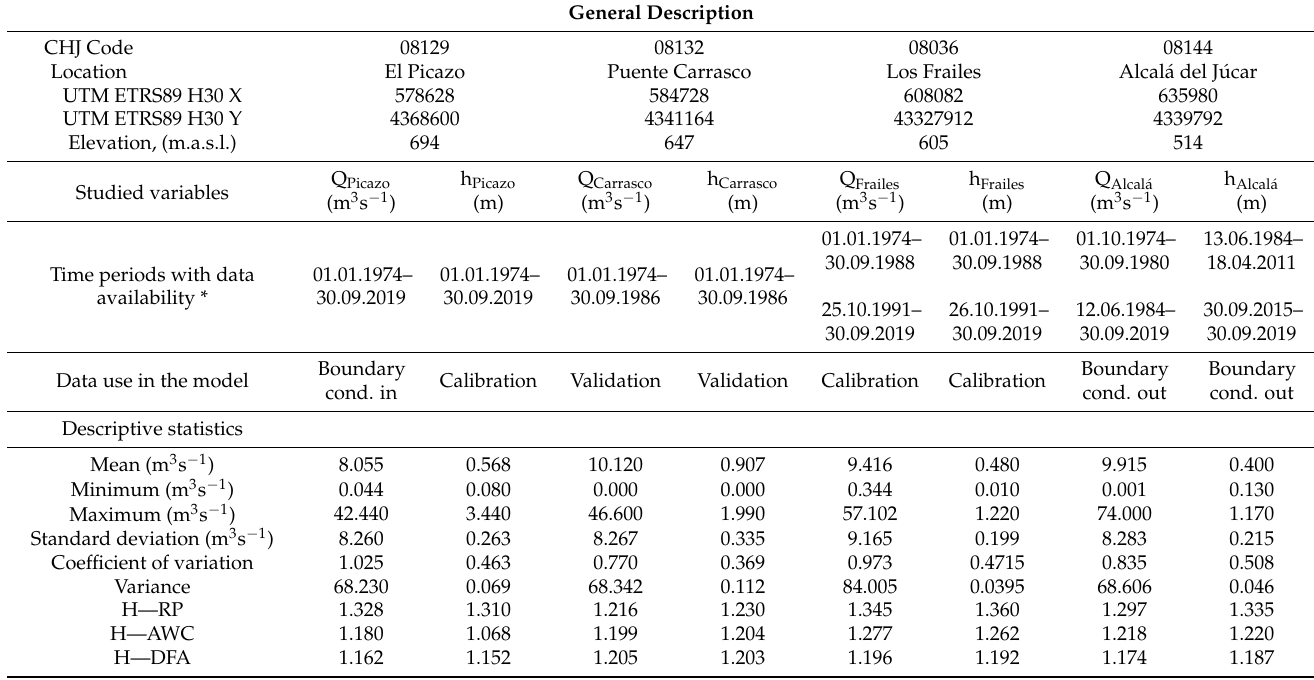
Table 1. General description and descriptive statistics of the observed daily time series with mean values for river discharge (Q, (m 3 s − 1 )) and depths (h, (m)) obtained from four gauging stations with available information for the period 01.01.1974–30.09.2019 and used for the purposes of the modeling. The location of the gauging stations can be seen in Figure 1 and their cross sections in Figure 2. The Hurst coefficients H were estimated using regression on periodogram (RP), averaged wavelet coefficients (AWC) and the detrended fluctuation analysis (DFA)